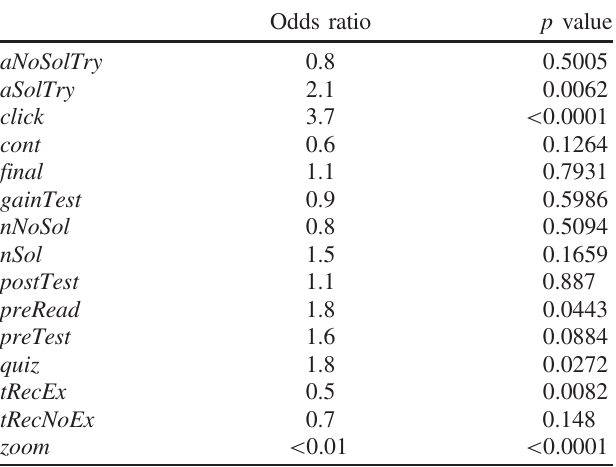
TABLE IV. Fisher ’ s exact test comparison of populations with above- and below-average classroom attendance with respect to above- and below-average values on the remaining